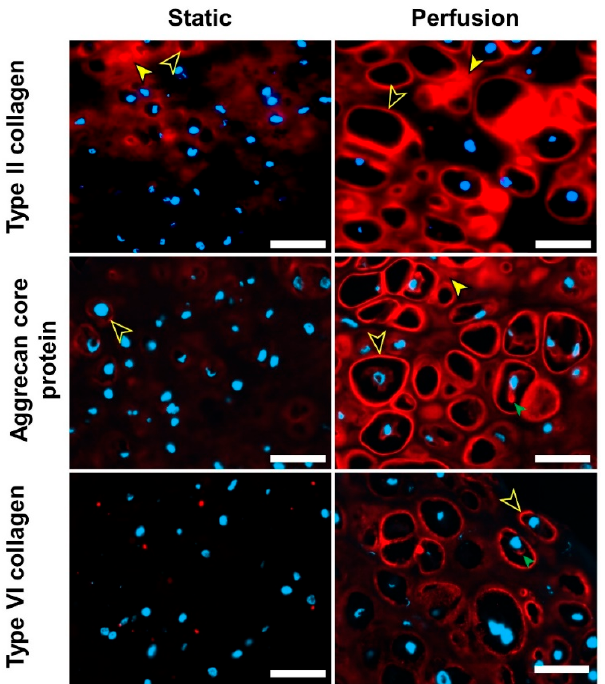
Figure 4. HACs self-isolate in a pericellular matrix similar to native cartilage when direct fluid-flow is applied. Representative immunofluorescence staining for type II collagen, aggrecan core protein, and type VI collagen. Proteins of interest were stained with the Alexa Fluor 488-conjugated secondary antibody (red). Nuclei were stained with Hoechst dye (blue). Arrows indicate pericellular immunostaining (black core and yellow border arrows), diffuse immunostaining in the extracellular space (yellow core and black border arrows) and intracellular immunostaining (small-sized green arrows) (scale bars = 50 µm) ( n = 3).